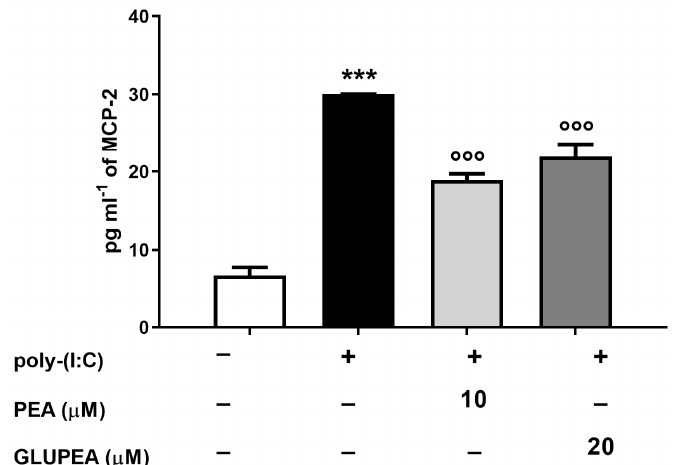
Figure 5. Effect of GLUPEA on MCP-2 chemokine levels in polyinosinic-polycytidylic acid (poly- (I:C))-induced allergic contact dermatitis (ACD) in HaCaT keratinocytes. MCP-2 chemokine levels were measured in the supernatants of poly-(I:C)-stimulated HaCaT cells (100 µ g · mL − 1 , 6 h, 37 ◦ C) in the presence of vehicle, PEA (10 µ M), or GLUPEA (20 µ M). Data are representative of n = 6 separate determinations (means + s.e.m.). Statistical analyses were carried out using one-way ANOVA followed by the Newman–Keuls multiple comparison test (*** p < 0.001 versus vehicle (i.e., cells without ACD); °°° p < 0.001 versus poly-(I:C)).